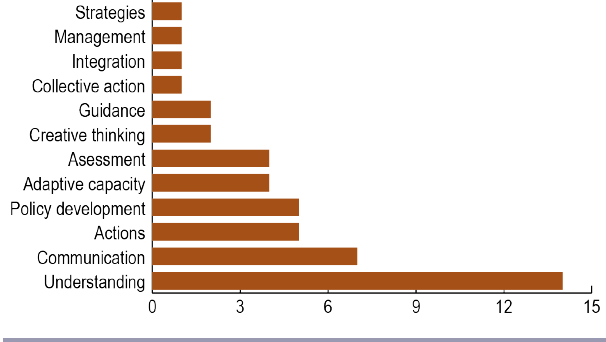
Fig. 1. Keywords used to describe the motivation for using participatory scenario